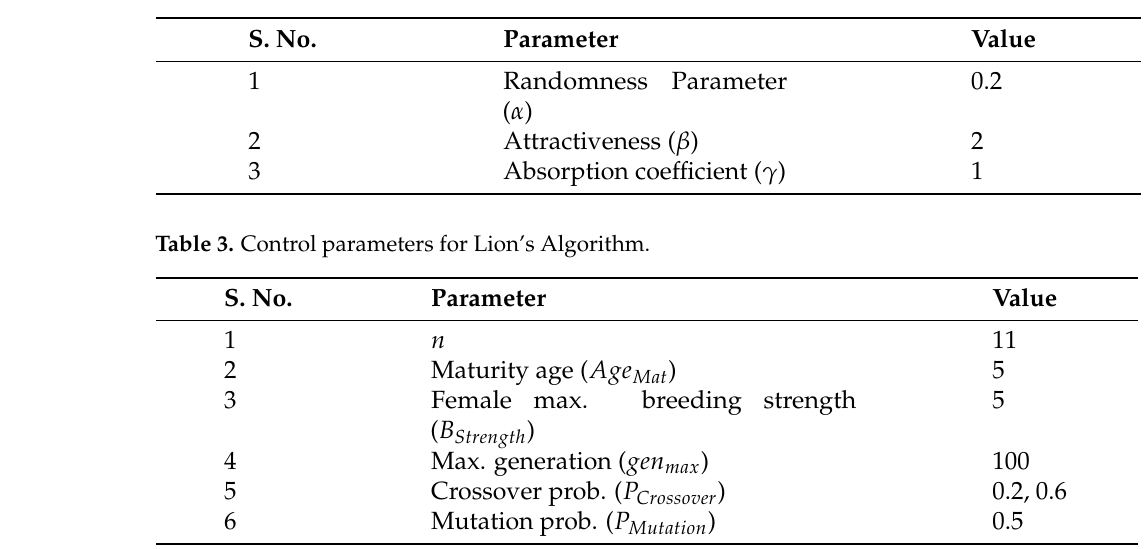
Table 2. Control parameters for Firefly Algorithm.